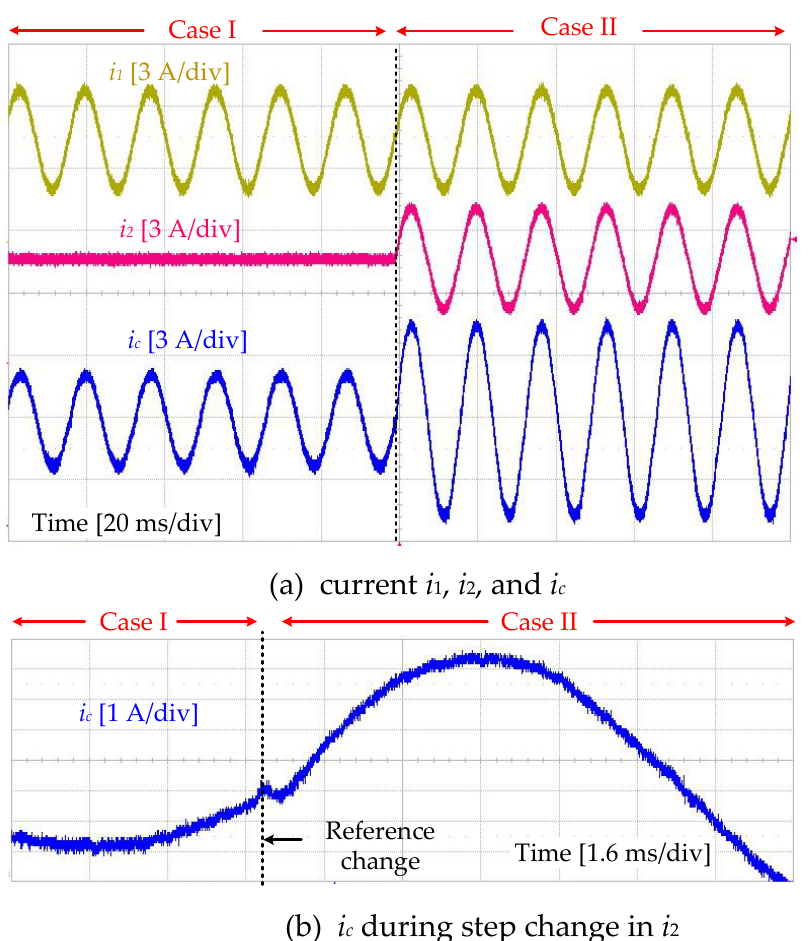
Figure 12. Experimental results for Cases I and II under the proposed control scheme.